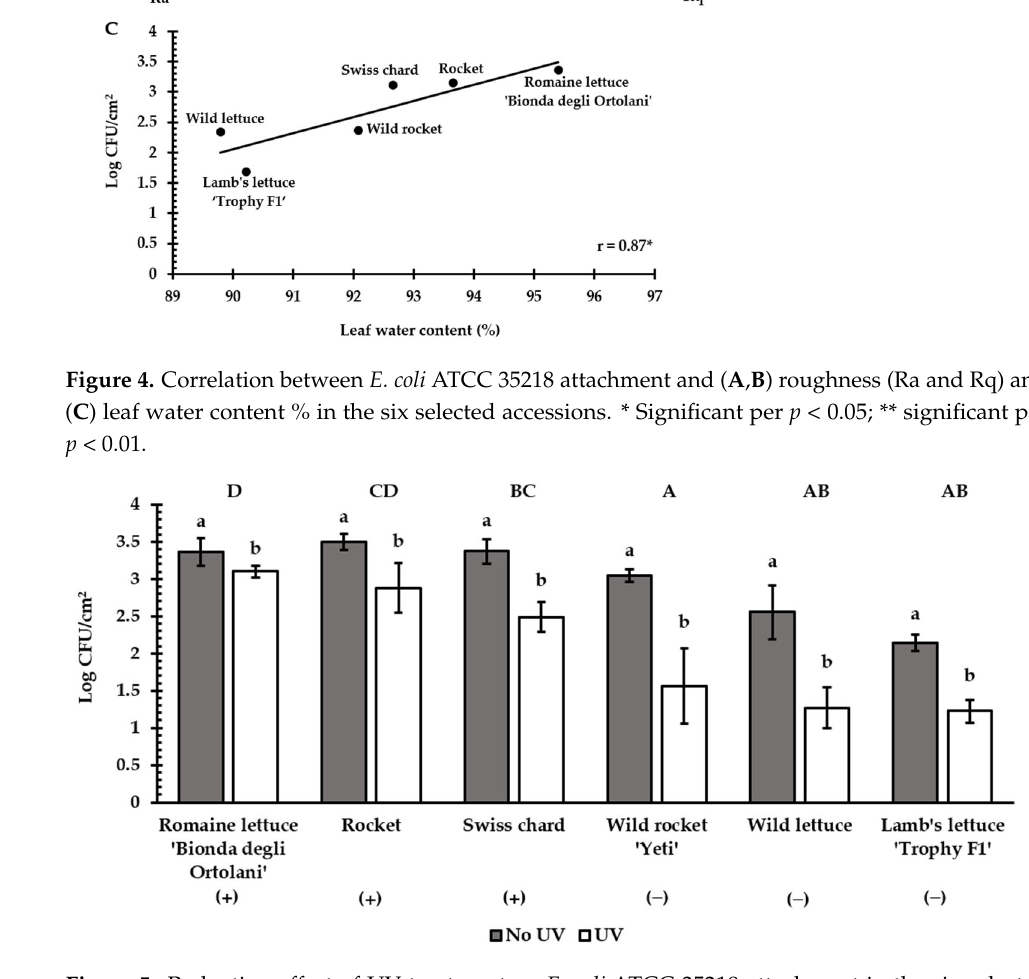
Figure 5. Reduction effect of UV treatment on E. coli ATCC 35218 attachment in the six selected accessions (+ = rougher; − = less rough). Different lowercase letters show significant differences ( p < 0.05) for each accession; different uppercase letters show significant differences ( p < 0.001) in the net bacterial population reduction between accessions (Tukey test, n = 5). Bars represent ± SD.